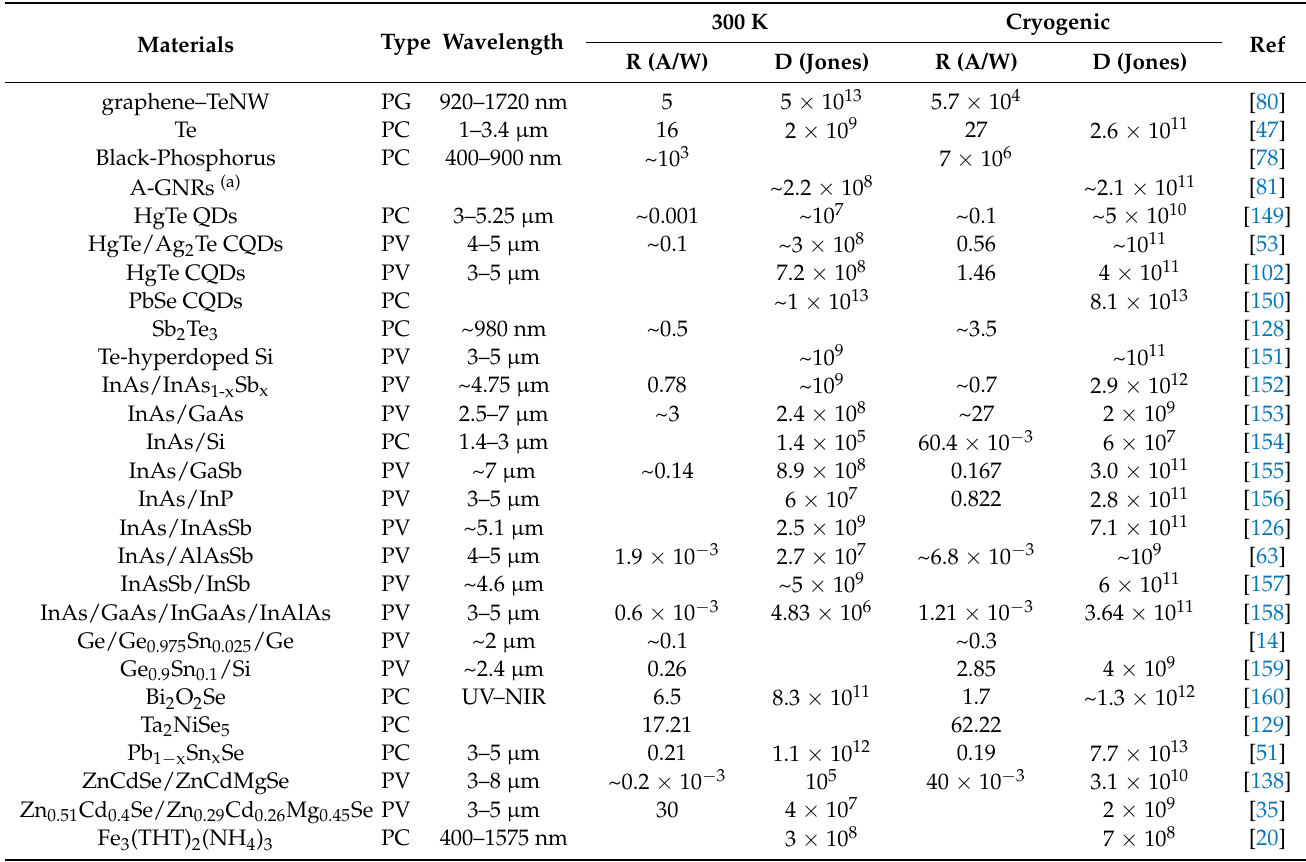
Table 2. Summary of cooling-enhanced photodetection performance.